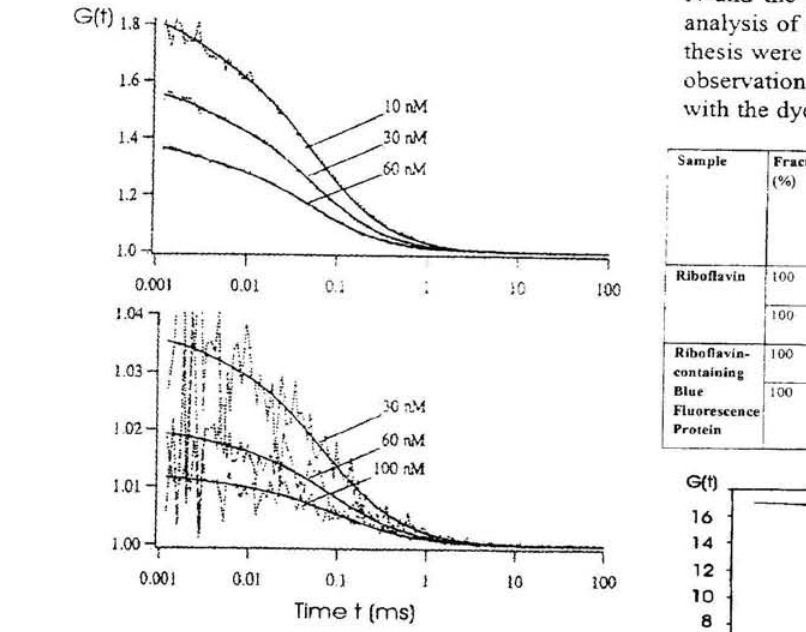
Figure 1. FCS experiments on riboflavin and riboflav in-containing blue fluorescence protein with laser excitation at 488 ran. The auto-correlation curves were taken from ref. (15). Upper panel: three different input concentrations of riboflavin using 800 μψ laser power. Lower panel: three different input concentra- tions of riboflavin-containing blue fluorescence pro- tein using 50 μ\ν laser power. The absolute and aver- aged number of molecules is directly obtained form the reciprocal value of the amplitude (minus one) of the diffusive part of the correlation function.